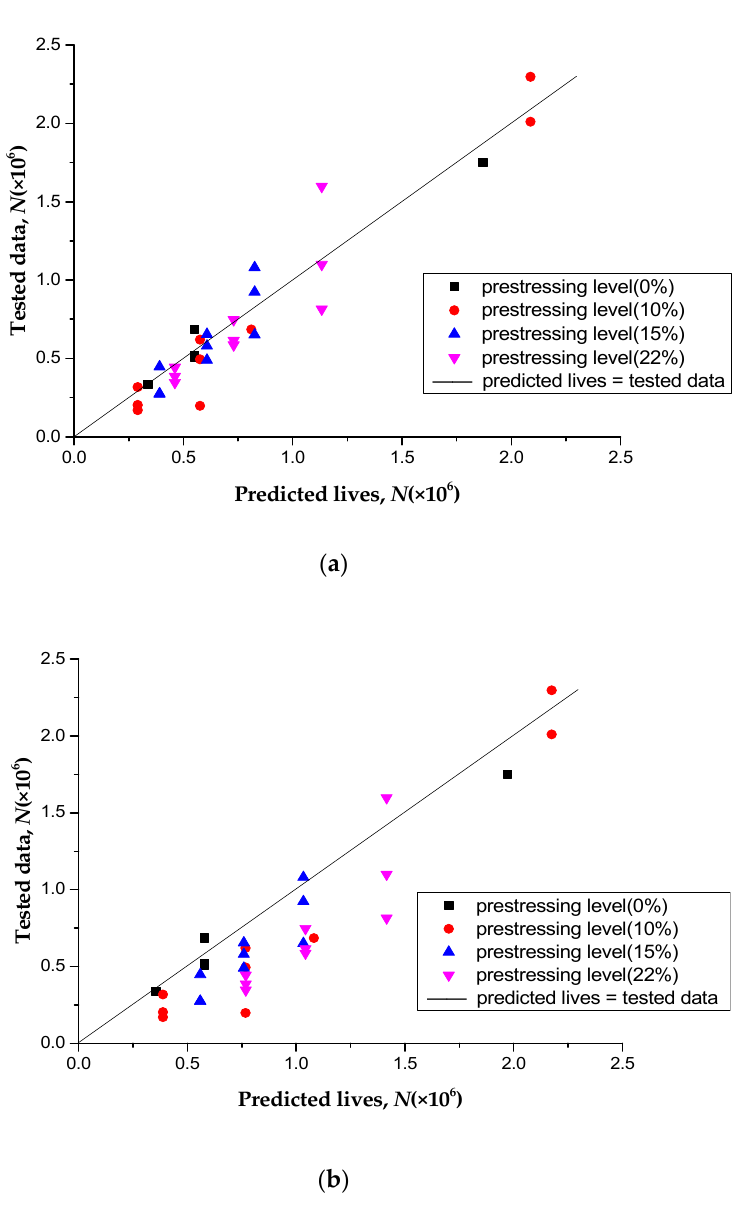
Figure 14. Tested data versus predicted lives for two models: ( a ) Considering the degradation of concrete performance; ( b ) Without considering the degradation of concrete performance. concrete performance; ( b ) Without considering the degradation of concrete